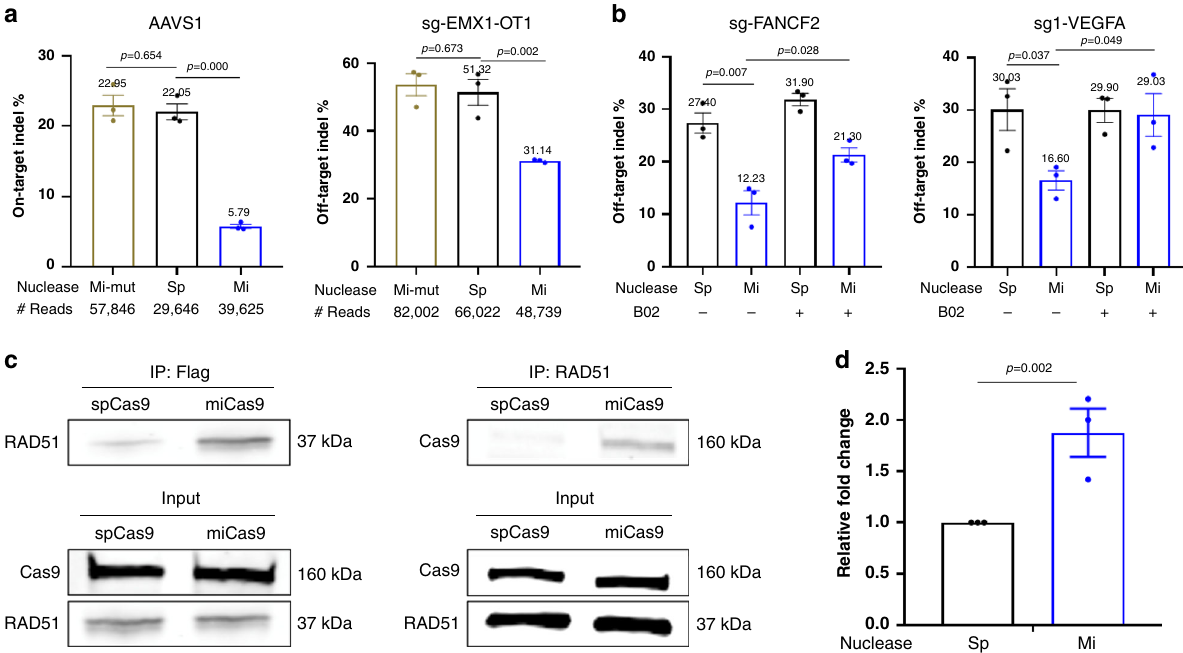
Fig. 6 MiCas9 ’ s bene fi cial effects are Brex27 and RAD51 dependent. a Indel rates by spCas9, miCas9, and miCas9-mutant at the on-target site for sg- AAVS1 and the off-target site 1 for sg-EMX1. b Indel rates estimated by T7E1 assay by spCas9 and miCas9 with or without the use of RAD51 inhibitor, B02. c Co-IP results by using anti- fl ag (left) or anti-RAD51 (right) antibodies followed western blot for RAD51 or Cas9. d ChIP assay results with anti-RAD51 antibody at the proximal region of the sg-AAVS1 target locus. Sp: spCas9, Mi: miCas9, Mi-mut: miCas9-mutant. # Reads: Average amplicon reads per sample. Three independent experiments were performed for each condition. Data are presented as mean ± standard error of means (SEM). Unpaired t- test (two tailed) was used to compare data using GraphPad Prism 8 software (GraphPad Software, Inc., San Diego, CA). Source data are available in the Source Data fi